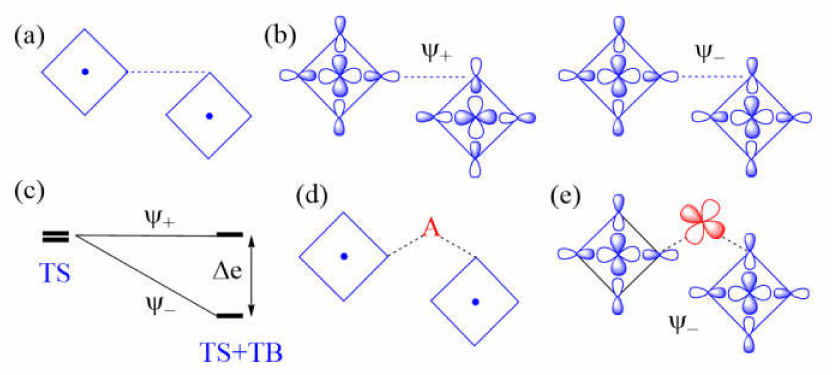
Figure 9. ( a ) A case of weak Cu–L . . . L–Cu spin exchange, where the two Cu–L bonds leading to the L . . . L contacts are orthogonal. ( b ) The in-phase and out-of-phase combinations ( Ψ + and Ψ − , respectively) of the two magnetic orbitals. ( c ) The vanishing energy split through-space (TS) interaction in the Cu–L . . . L–Cu exchange is enhanced in the Cu–L . . . A . . . L–Cu exchange as a result of the through-bond (TB) interaction that occurs primarily with the Ψ